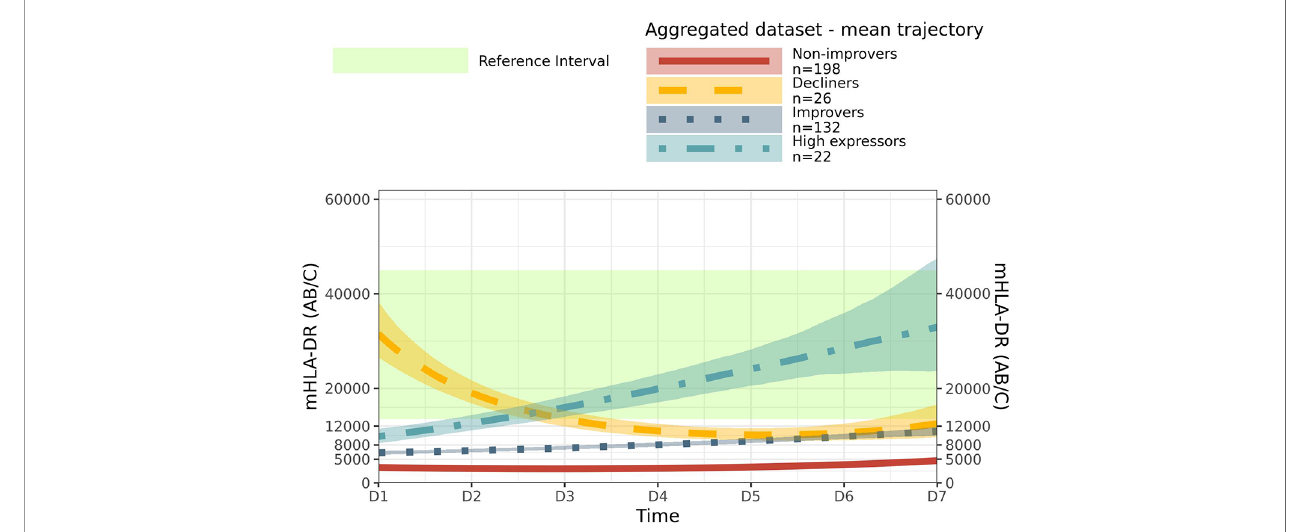
FIGURE 2 | Mean trajectory per endotype in aggregated dataset. Mean trajectory of mHLA-DR endotypes in aggregated dataset were together drawn. Non- Improvers (red, plain line), Decliners (gold, long dashed line), Improvers (dark blue, dotted line) and High expressors (light blue, dashed and dotted line). 95% con fi dence intervals were drawn as areas around mean trend. The green area represents Healthy Volunteers reference interval, has de fi ned in (14).